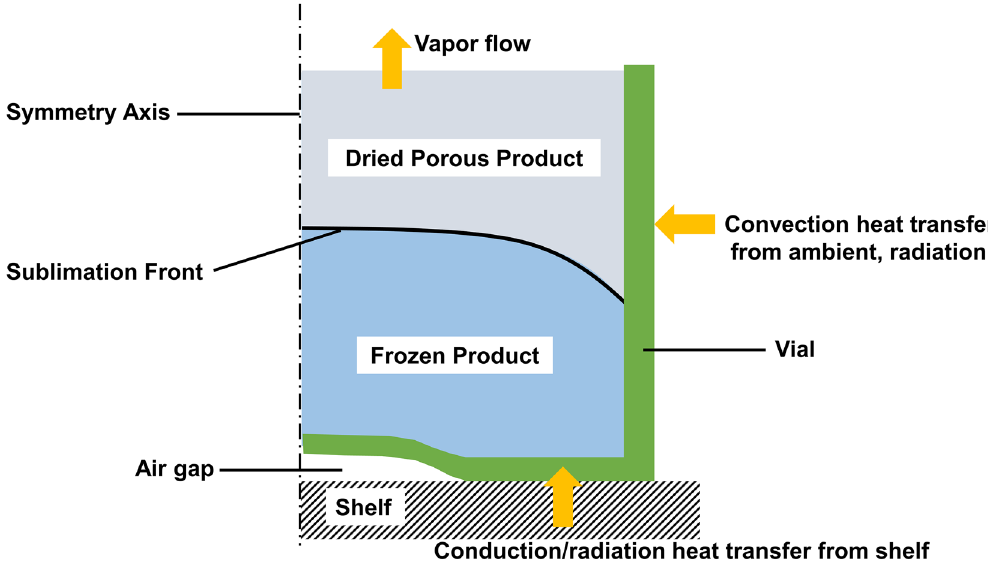
Figure 6. Heat transfer mechanisms between the vial, product, shelf and ambient during the primary drying stage of lyophilization